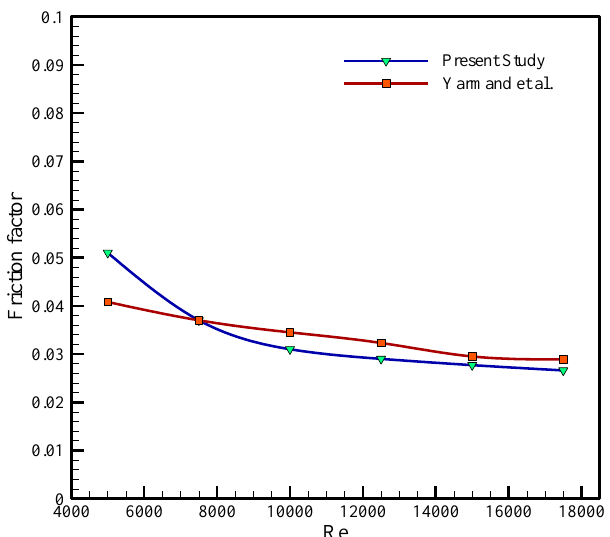
Figure 5. Comparison of friction factor of the current study and Yarmand et al. [34] investigation. The above comparisons indicated that the present modeling had enough reliability, and data were reliable for further